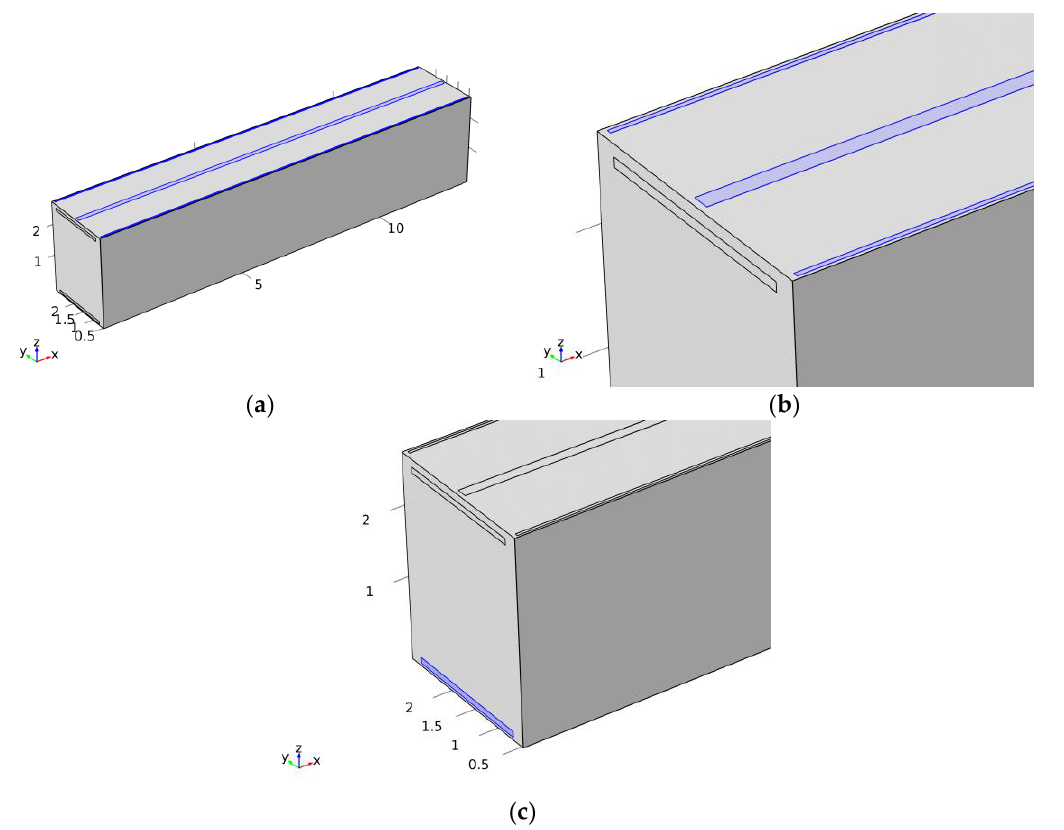
Figure 4. Location of inlets and outlet ( a ) inlets are highlighted on the ceiling of the container, ( b ) close-up view of the inlets (highlighted), ( c ) outlet (highlighted).